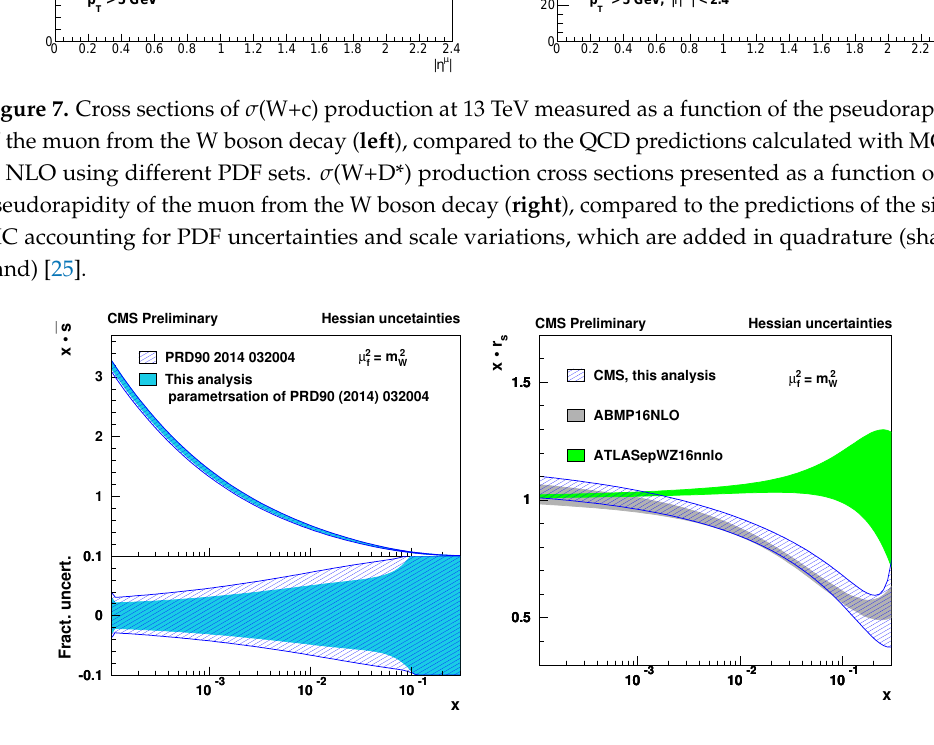
Figure 8. The distributions of s quark ( left upper panel) in the proton and its relative uncertainty ( left lower panel) as a function of x at the factorization scale of m 2 band) is compared to the result of a previous measurement [26].The strangeness suppression factor as a function of x ( right ) at the factorization scale of m 2 and ATLASepWZ16nnlo (light shaded band) PDFs